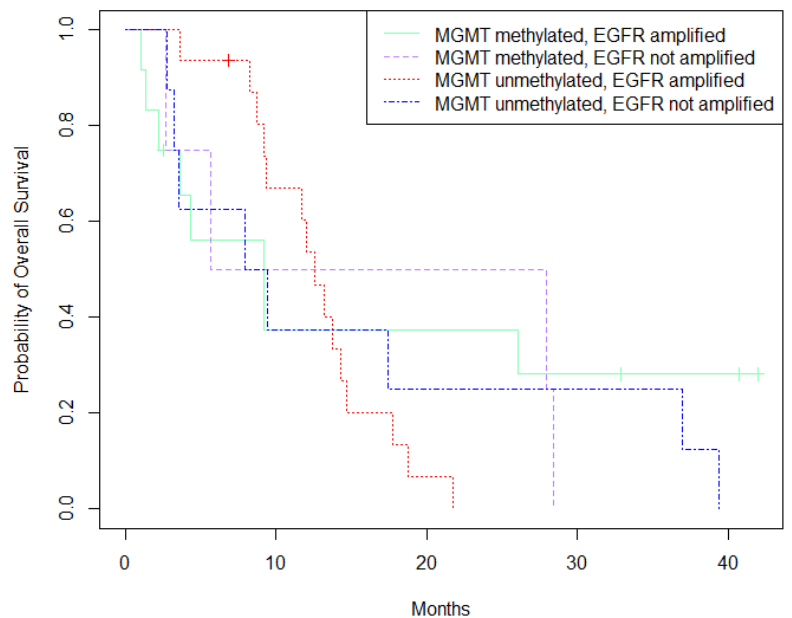
Figure 2. Survival analysis (Kaplan-Meier) based on MGMT-methylation and EGFR-expression